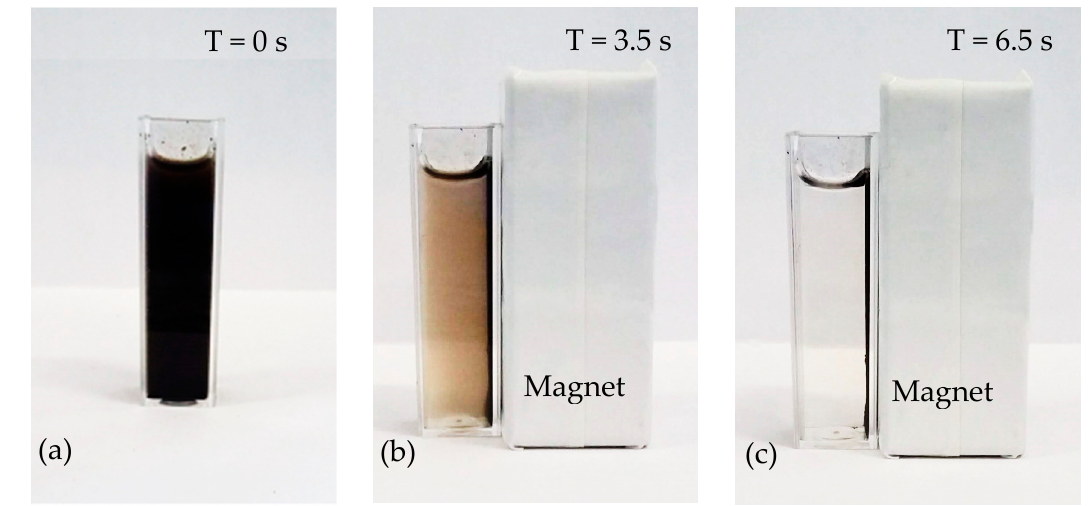
Figure 1. Images of magnetic CLEA separation by applying an external magnetic field: ( a ) CLEA suspension, ( b ) magnetic field capturing the CLEA, and ( c ) CLEA separated from the suspension.